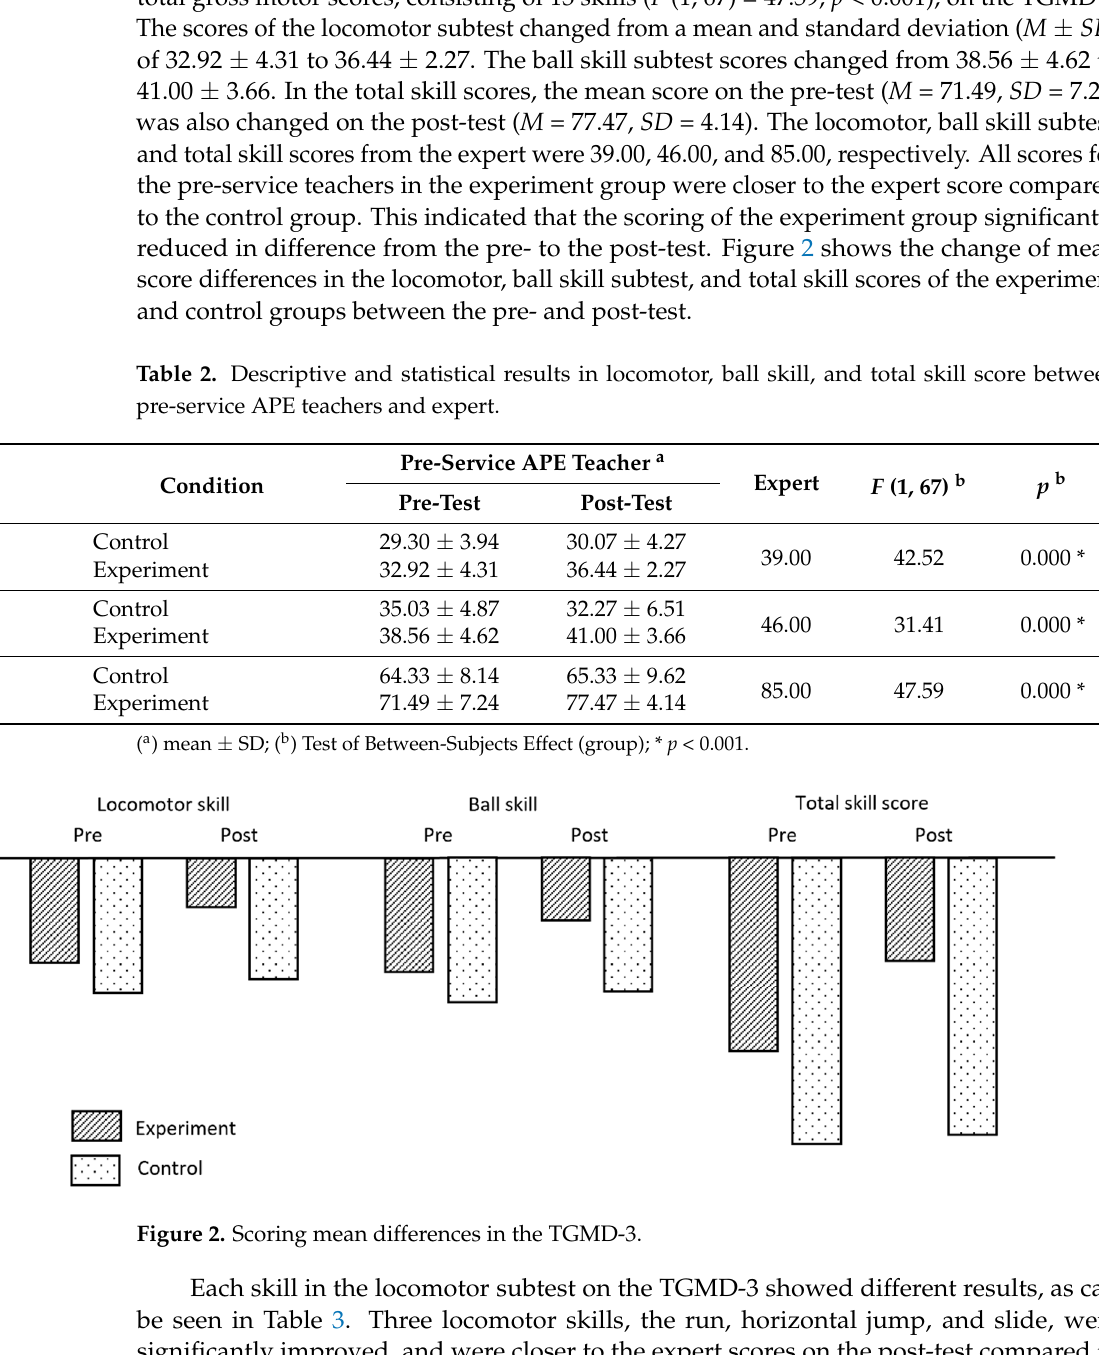
Table 3. Descriptive and statistical results of the TGMD-3 skill score comparison between pre-ser- vice APE teachers and expert.